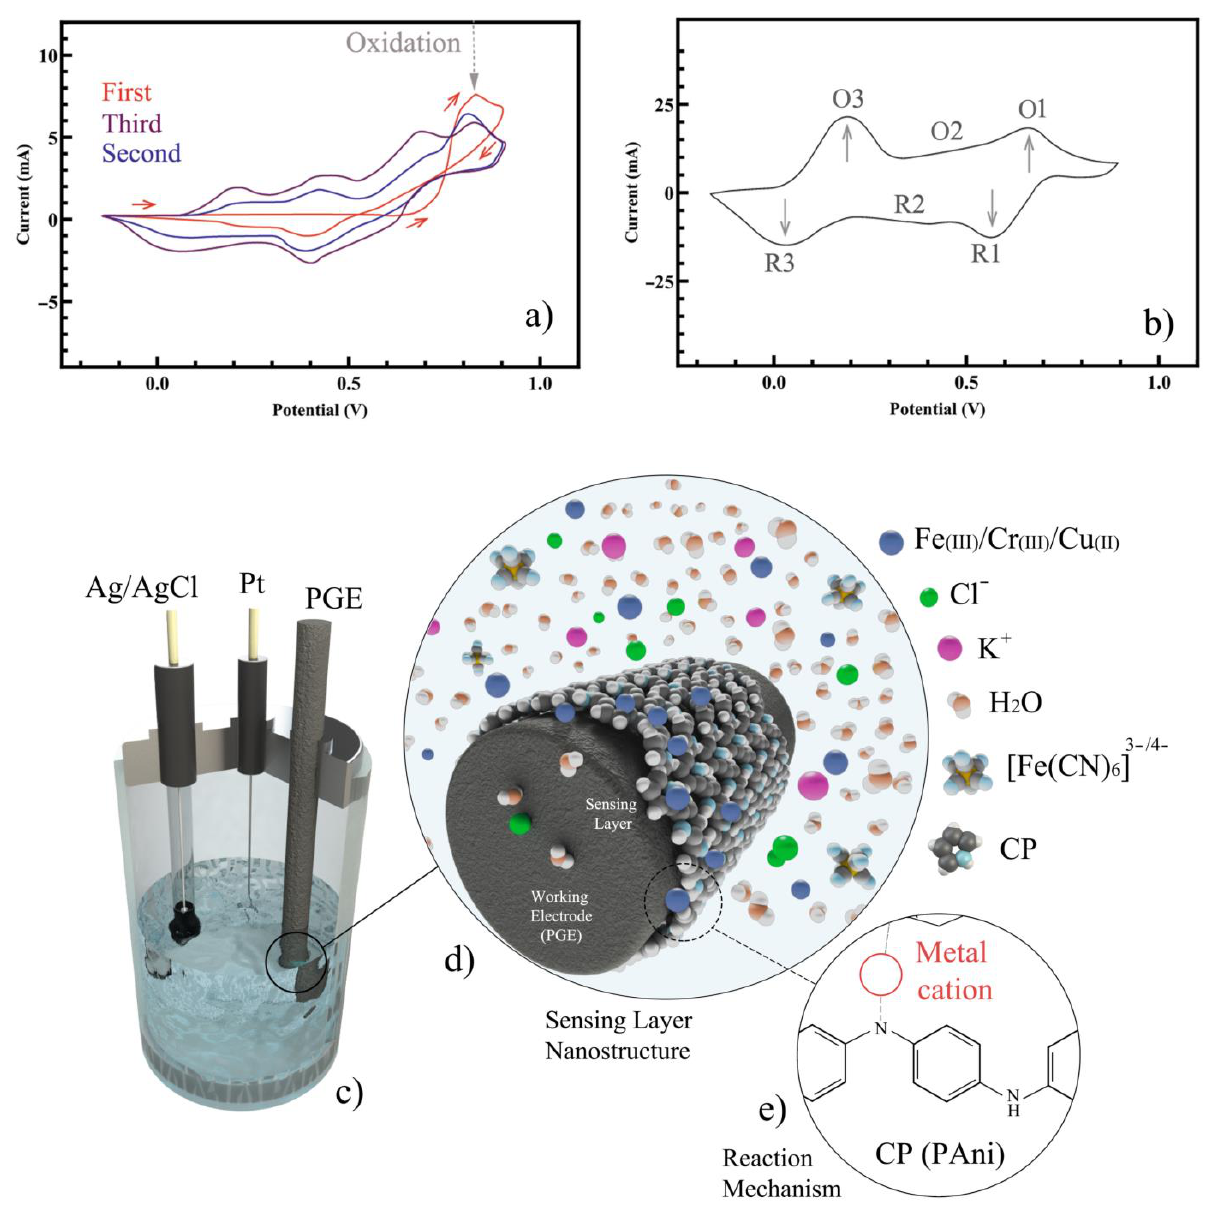
Figure 1. CV of PAni for ( a ) deposition and ( b ) the characterization. ( c ) The schematic of the test setup with the three- electrode cell. ( d ) Deposition of the CP on the surface of the PGE. ( e ) Reaction between PAni and the analyte.